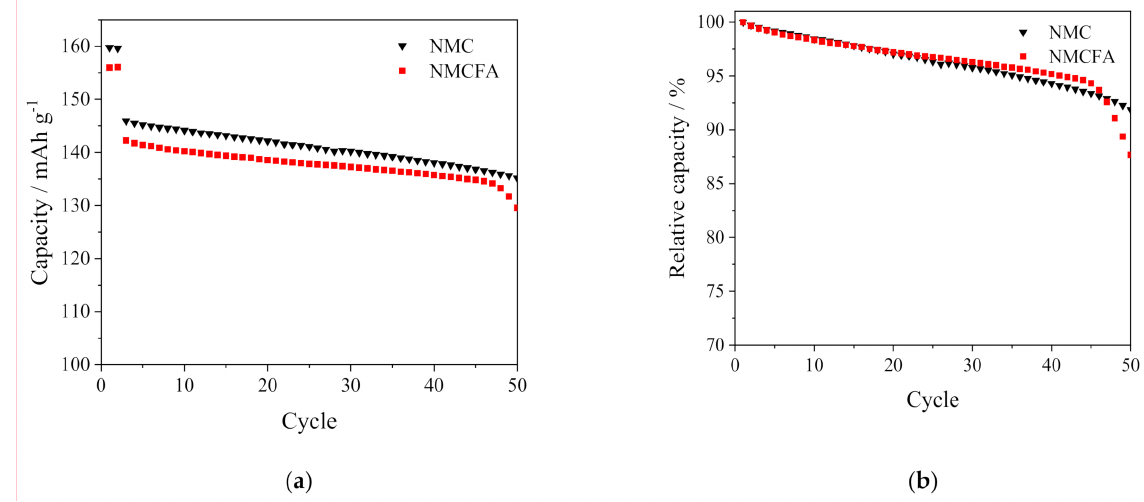
Figure 8. ( a ) Cycling performance and ( b ) capacity retention of the NMC and NMCFA at 1